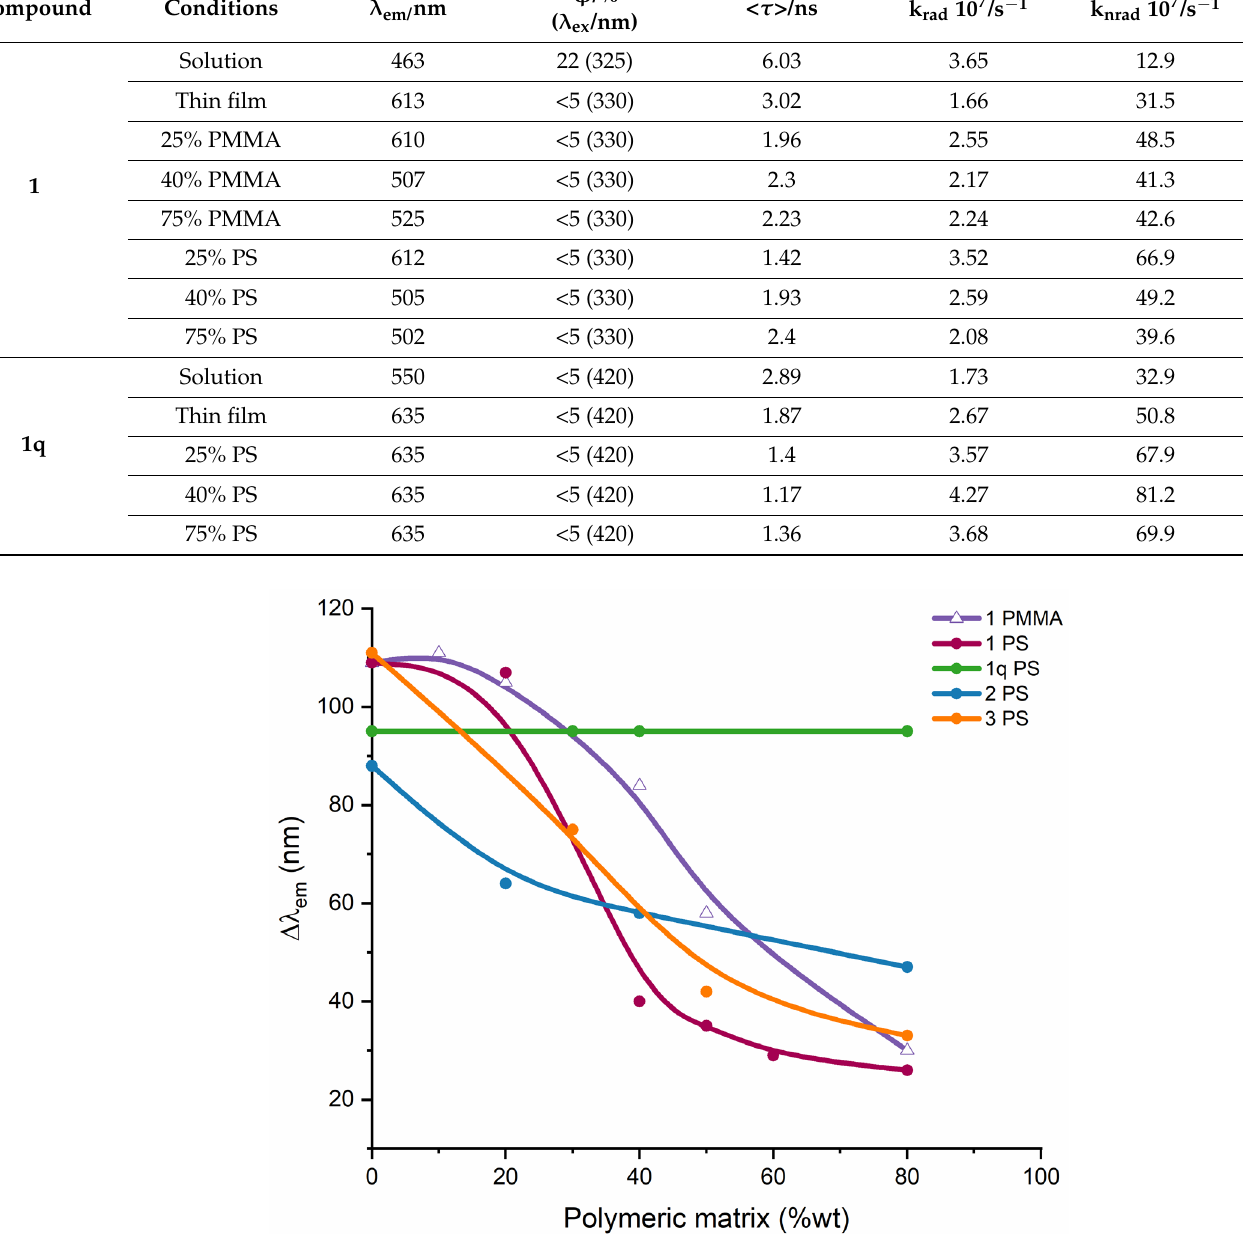
Table 2. Photophysical characterization of 1 and 1q in pristine thin film or with different %wt of polymeric matrices. Compound